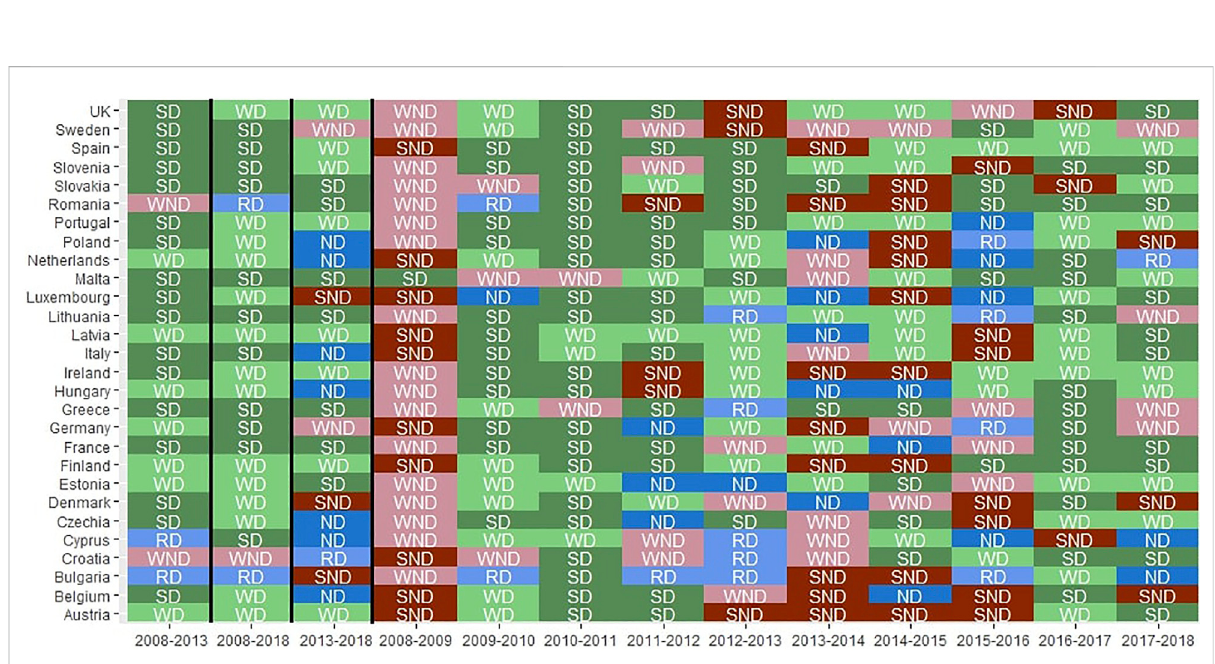
FIGURE 4 CH 4 emissions decoupling. Source: authors ’ calculation based on EEA,